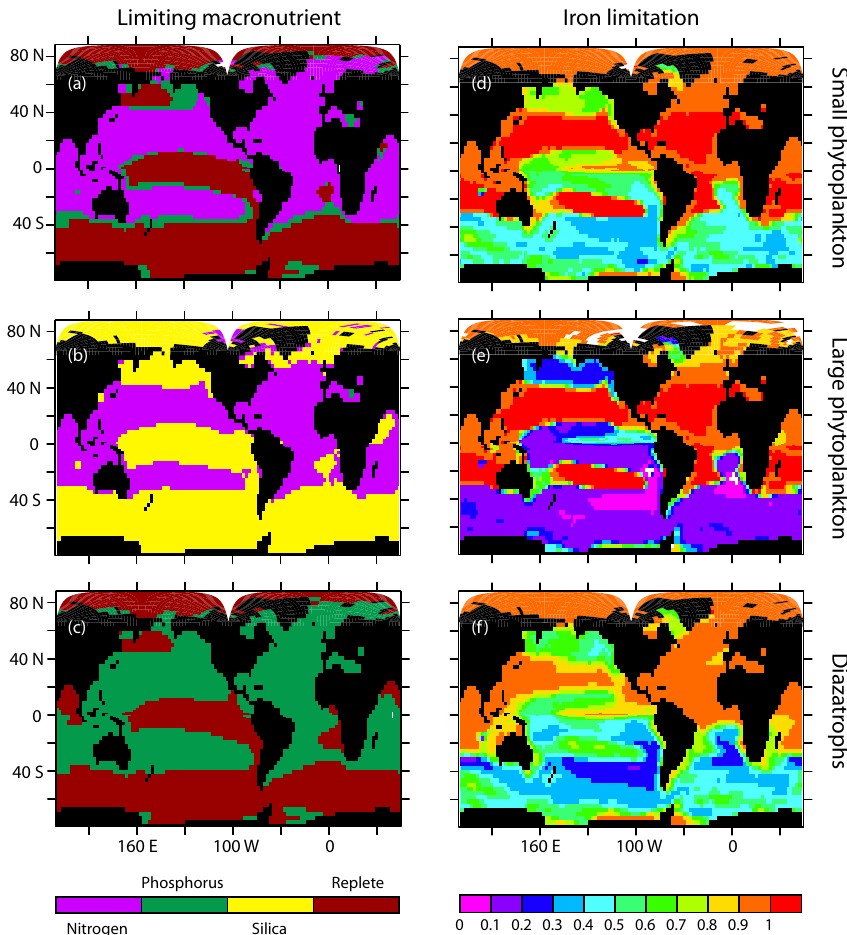
Fig. 1. The left column shows which macronutrient is limiting small phytoplankton (top), large phytoplankton (middle), and diazotrophs (bottom). These results are the three month summer averages for each hemisphere calculated from the control simulation after a 1000 year spin-up. Replete is defined as minimum limitation ≥ 0.965. The right column shows the average summertime magnitude of the iron-light colimitation term divided by the magnitude of the iron-light co-limitation term when iron is assumed to be replete. In other words, it is a 0 to 1 measure of the iron contribution to iron-light